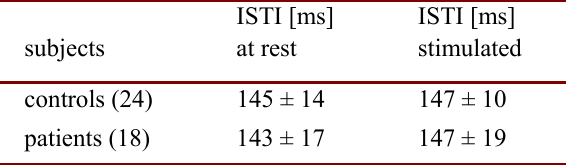
Table 2. ISTI-interval ± S.D. [ms] in the group of patients with Parkinson’s disease and in the group of control subjects while breathing at rest and during stimulated, deep breathing at 0.1